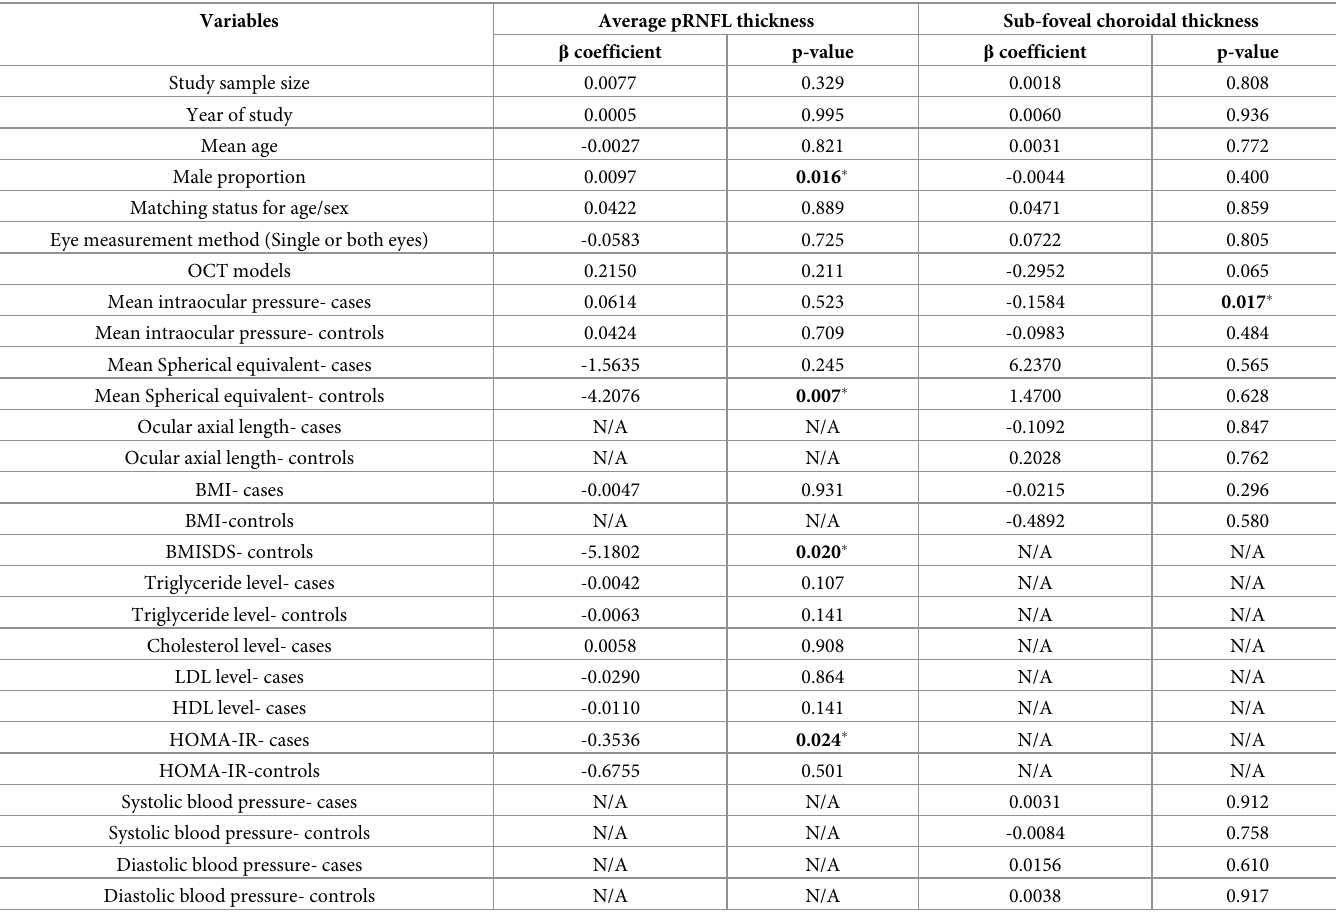
Table 3. Detailed results of performed